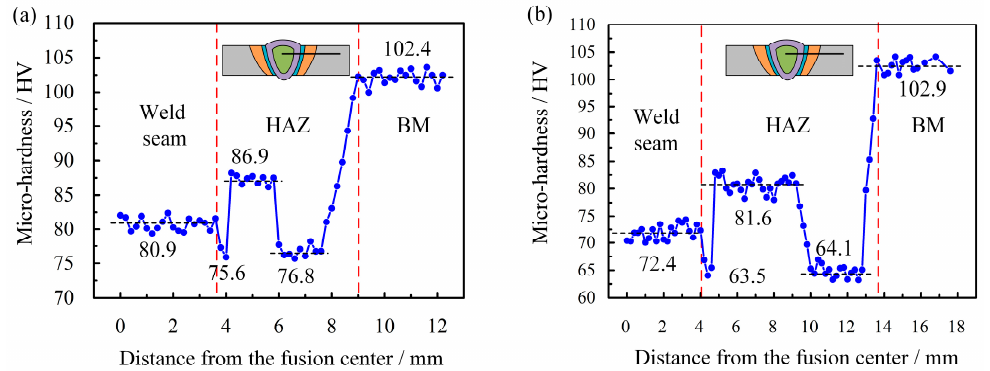
Figure 8. Micro-hardness profiles of the hybrid welded joints. ( a ) laser-CMT hybrid welded joint; ( b ) plasma-CMT hybrid welded joint.